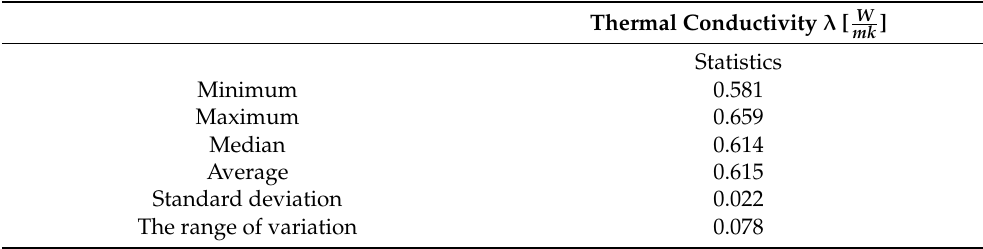
Table 10. Average thermal conductivity for basalt dust B for all samples for water − mix ratio = 0.7.